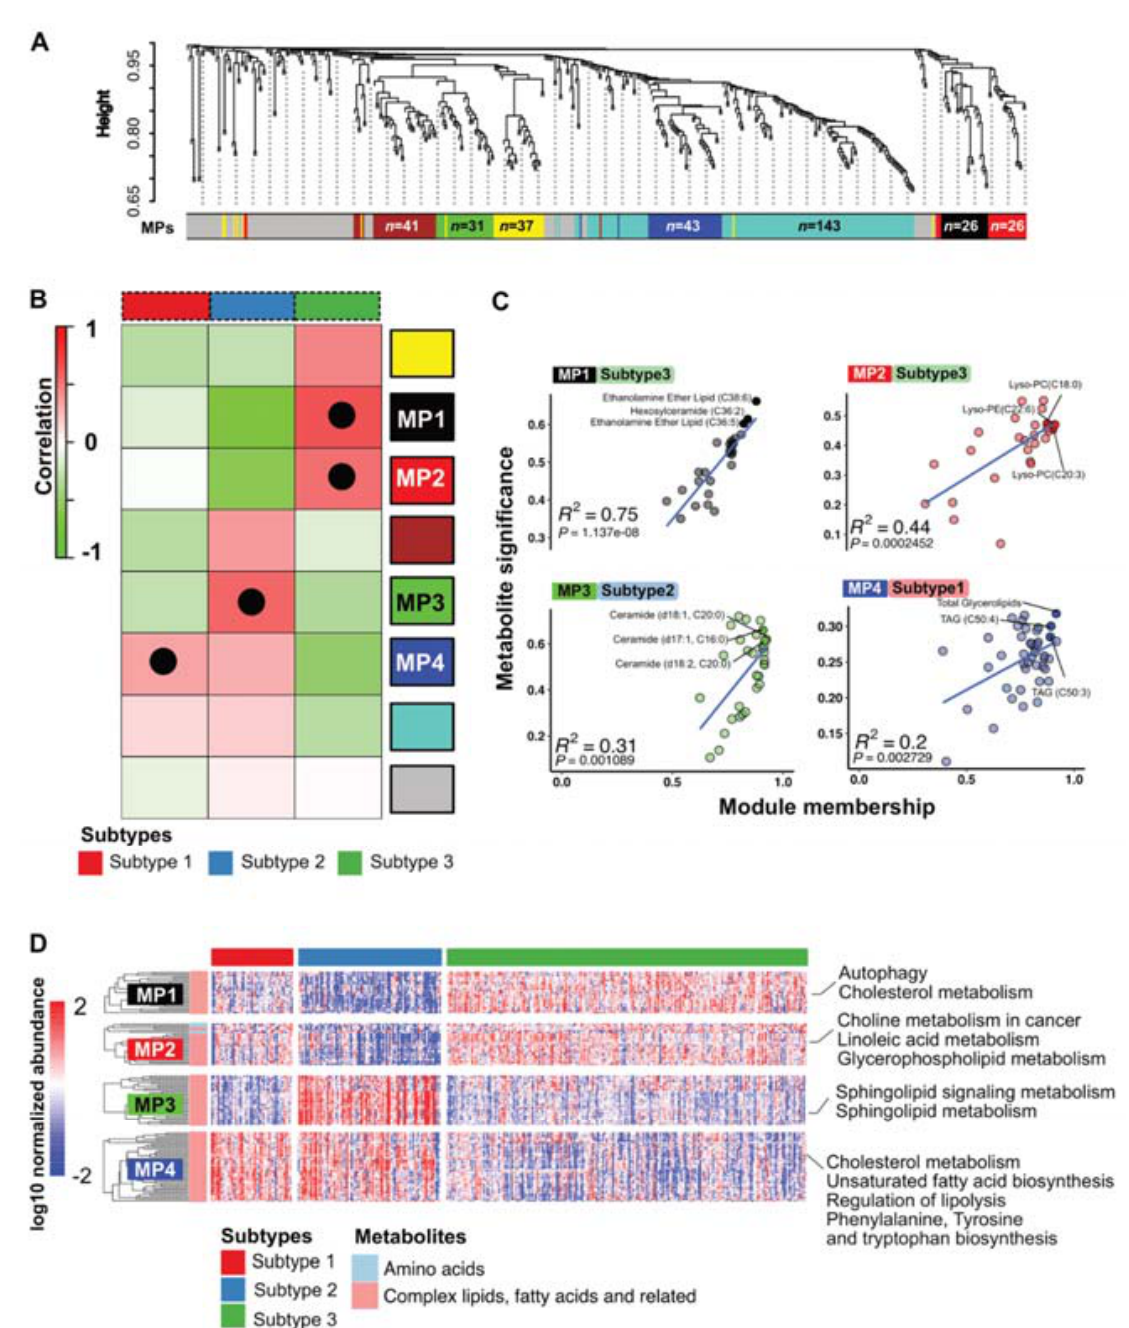
Figure 4. Core metabolic programs (MPs) define metabolic subtypes: ( A ) WGCNA cluster dendrogram of differentially expressed metabolites. Each leaf (vertical line) in the dendrogram corresponds to a metabolite. The colored row underneath the dendrogram shows the assigned modules, called metabolic programs (MPs). ( B ) Heatmap of metabolic programs (MPs) that were correlated to metabolic PDAC subclasses. Black dots denote metabolic networks with highest significance for a PDAC subclass. ( C ) Scatter plot depicts correlations between enriched metabolic programs (MPs) and metabolic subtype. The three most significant metabolites are named. Pearson correlation coefficient and p -value are presented in the plot. p -value < 0.05 is considered significant. ( D ) Heatmap represents differential pattern of log10 normalized metabolites abundance in the specified MPs that showed the highest correlation to the metabolic subtypes.